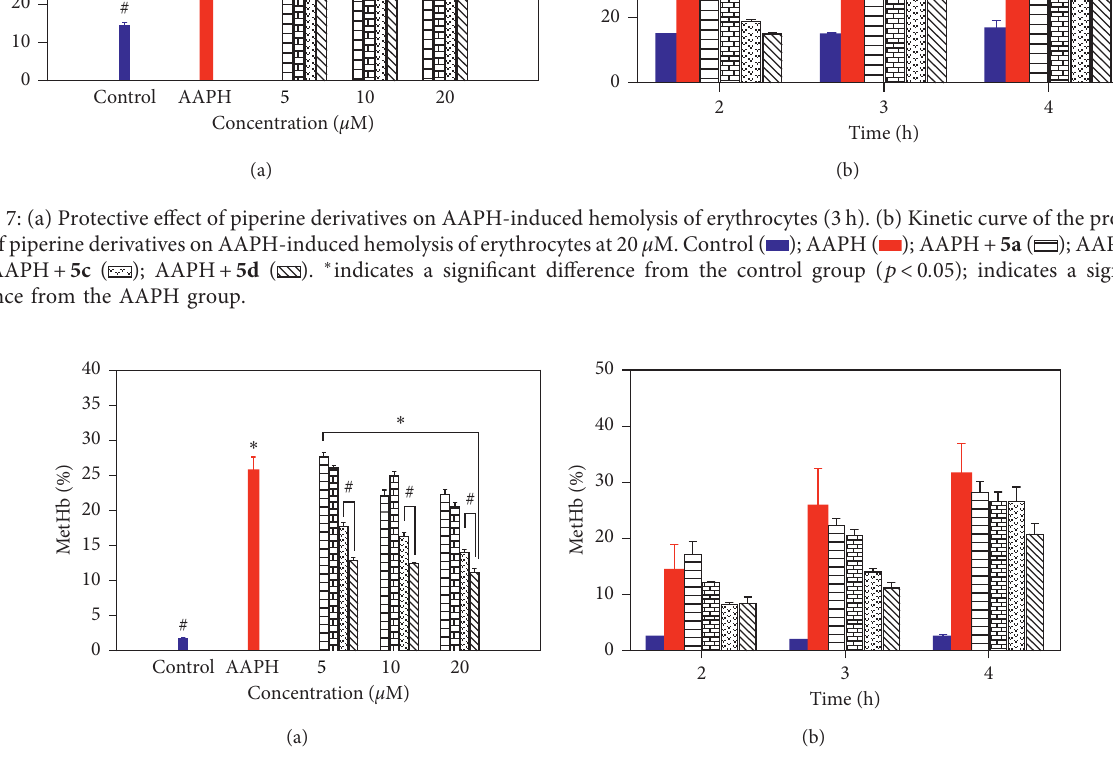
Figure 8: (a) Protective effects of piperine derivatives on AAPH-induced hemoglobin oxidation (3h). (b) Kinetic curve of the protective effect of 20 μ M piperine derivatives on AAPH-induced hemoglobin oxidation. Control ( ); AAPH ( ); AAPH+ 5a ( ); AAPH+ 5b ( ); AAPH+ 5c ( ); AAPH+ 5d ( ). ∗ indicates a significant difference from the control group ( p < 0 . 05); # indicates a significant difference from the control group ( p < 0 . 05).